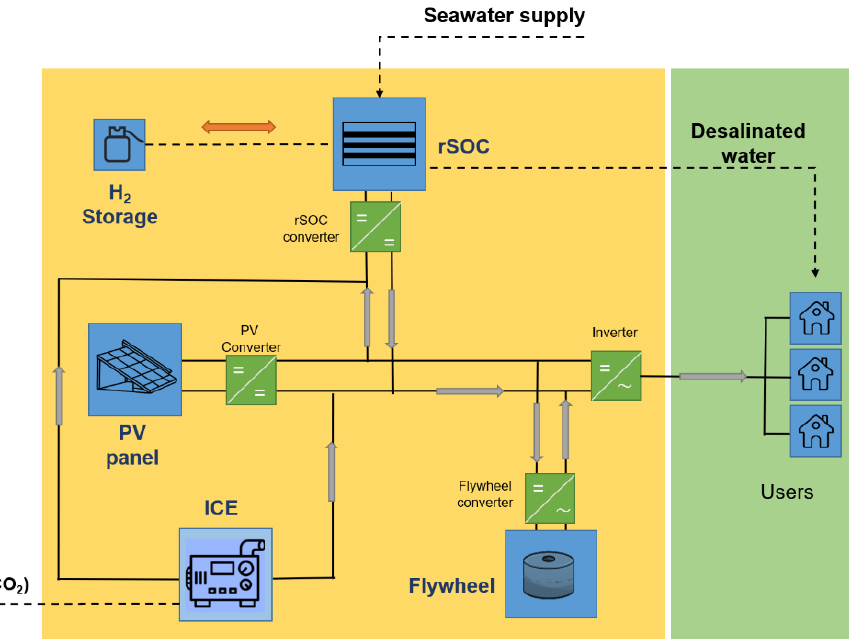
Figure 6. Hybrid Energy Storage System: schematic architecture for stand-alone mini-grids.